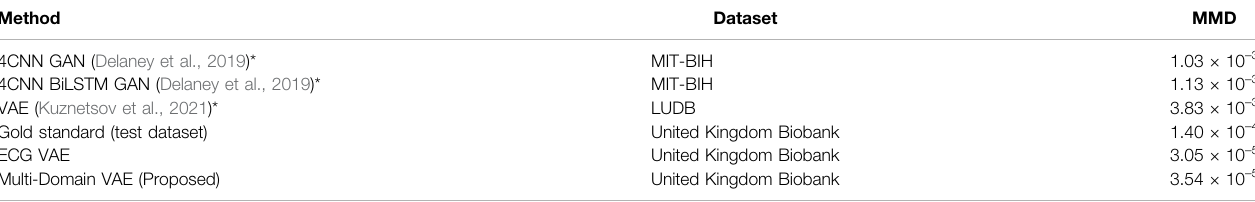
TABLE 3 | ECG generation results of multiple methods based on different datasets.